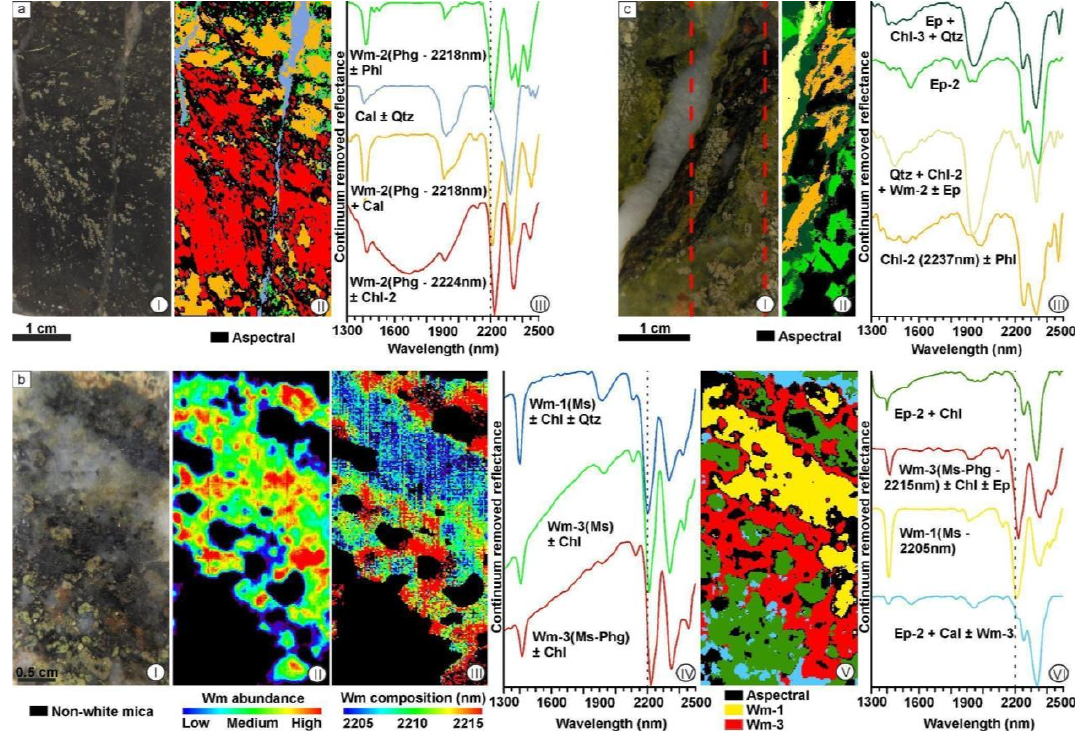
Figure 6. Images and spectra derived from SisuCHEMA data from drill core samples. The colors of the spectra are the key for the mineral maps. ( a ) Group 1 chloritic zone in the phyllonite, where calcite-quartz veinlets cut the Wm–2 and Chl–2 foliation (sample BH020-019): (I) true color image, (II) spectrally predominant mineral map (156 µ m pixel resolution), and (III) main spectra derived from Figure 6aII. ( b ) Group 2 phyllic zone overprinted by propylitic zones (sample BH059-009): (I) true color image, (II) white mica relative abundance map (156 µ m pixel resolution), (III) Al-OH wavelength composition map, (IV) spectra derived from previous Figure 6bIII, (V) spectrally predominant mineral map, and (VI) spectra derived from Figure 6bV. Wm–1 (Al-OH feature at 2205nm) and Wm–3 (Al-OH feature at 2215 nm) are spectrally distinct. In the maps, Wm–1 is surrounded and superimposed by Wm–3. ( c ) Group 2 propylitic and epidote zones (Ep–3) over Group 1 alteration zones (Bt–1, Chl–1, and quartz) in the phyllonite (sample BH059-046): (I) true color image, (II) spectrally predominant mineral map (30 µ m pixel resolution), and (III) main spectra derived from Figure 6cII. Note the two overprinted alteration minerals: the epidote (Ep–1)–chlorite–(Chl–3)–quartz assemblage (propylitic zone) overprints the chlorite Chl–1-phlogopite Bt–1 (chloritic zone) phyllonite and quartz-sulfide veinlets, while epidote (Ep–2) from epidote zone overprints the propylitic alteration.